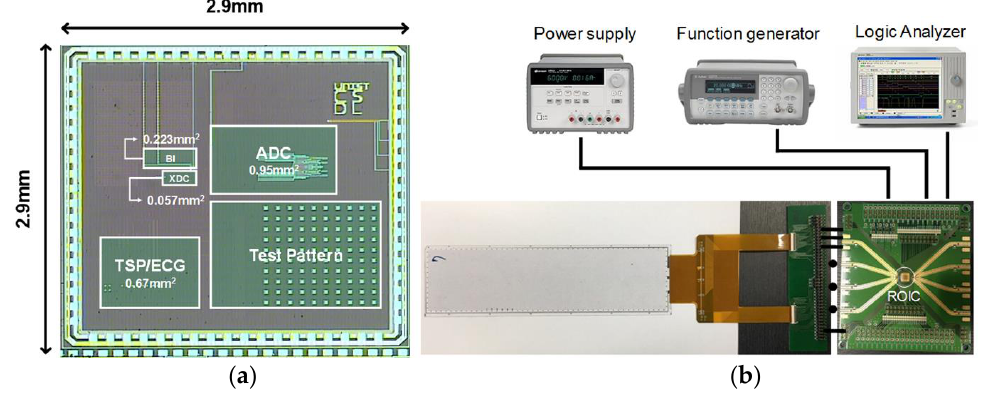
Figure 7. Proposed reconfigurable readout integrated circuit (ROIC) prototype: ( a ) microphotograph; ( b ) measurement setup.